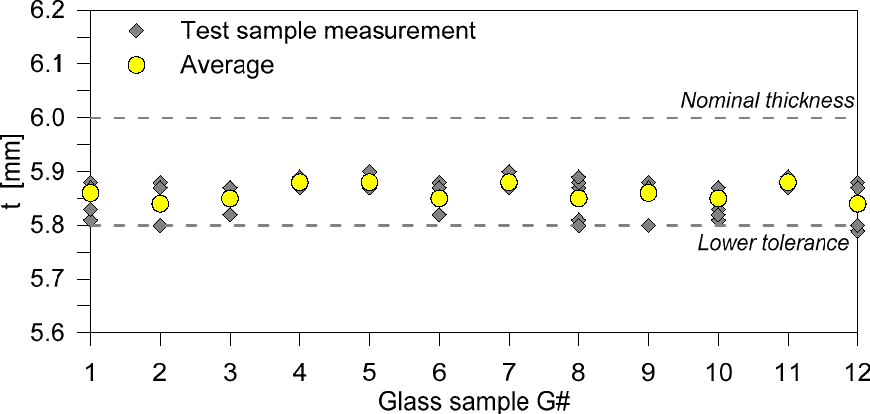
Figure 3. Preliminary measurements on the real thickness of the tested glass panels.